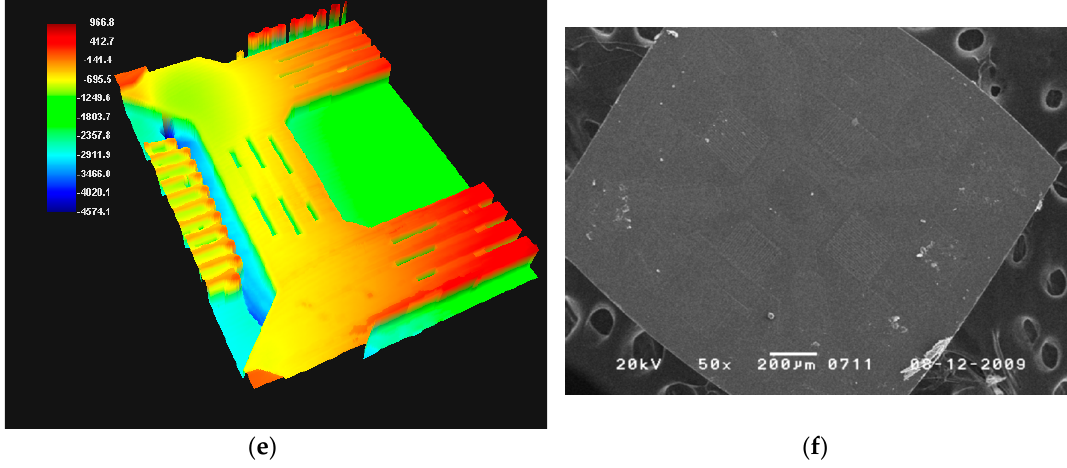
Figure 10. Three-dimensional (3D) profile result and scanning electron microscopy (SEM) images of ( a , b ) Teflon, ( c , d ) SU-8, and ( e , f ) PI.